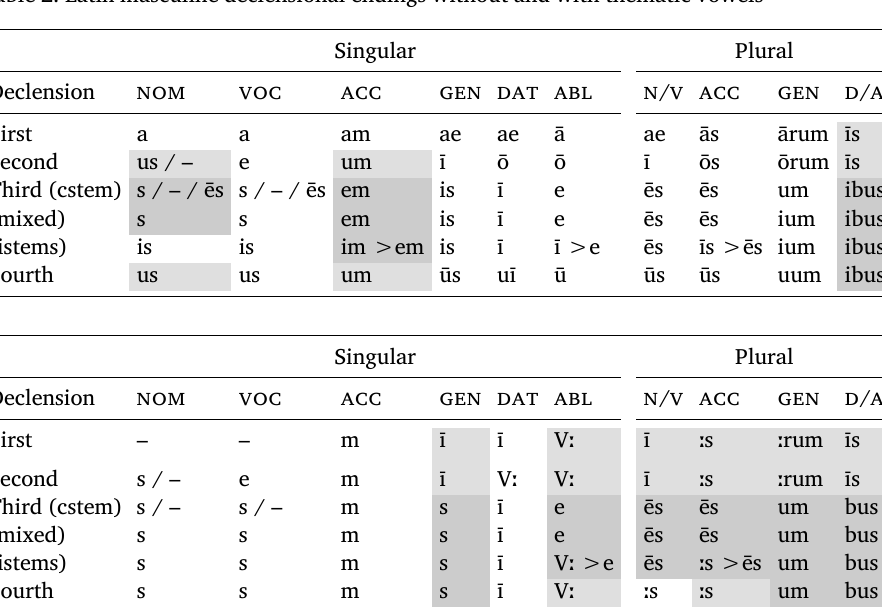
This table is adapted from Carstairs-McCarthy (1994, pp. 749-750). The sym- bol > means ‘tends to be replaced by’. Slashes separate affixes which are dis- tributed on a partly phonological, partly arbitrary basis. In each column, shades of gray highlight repeated affixes when they violate the No Blur